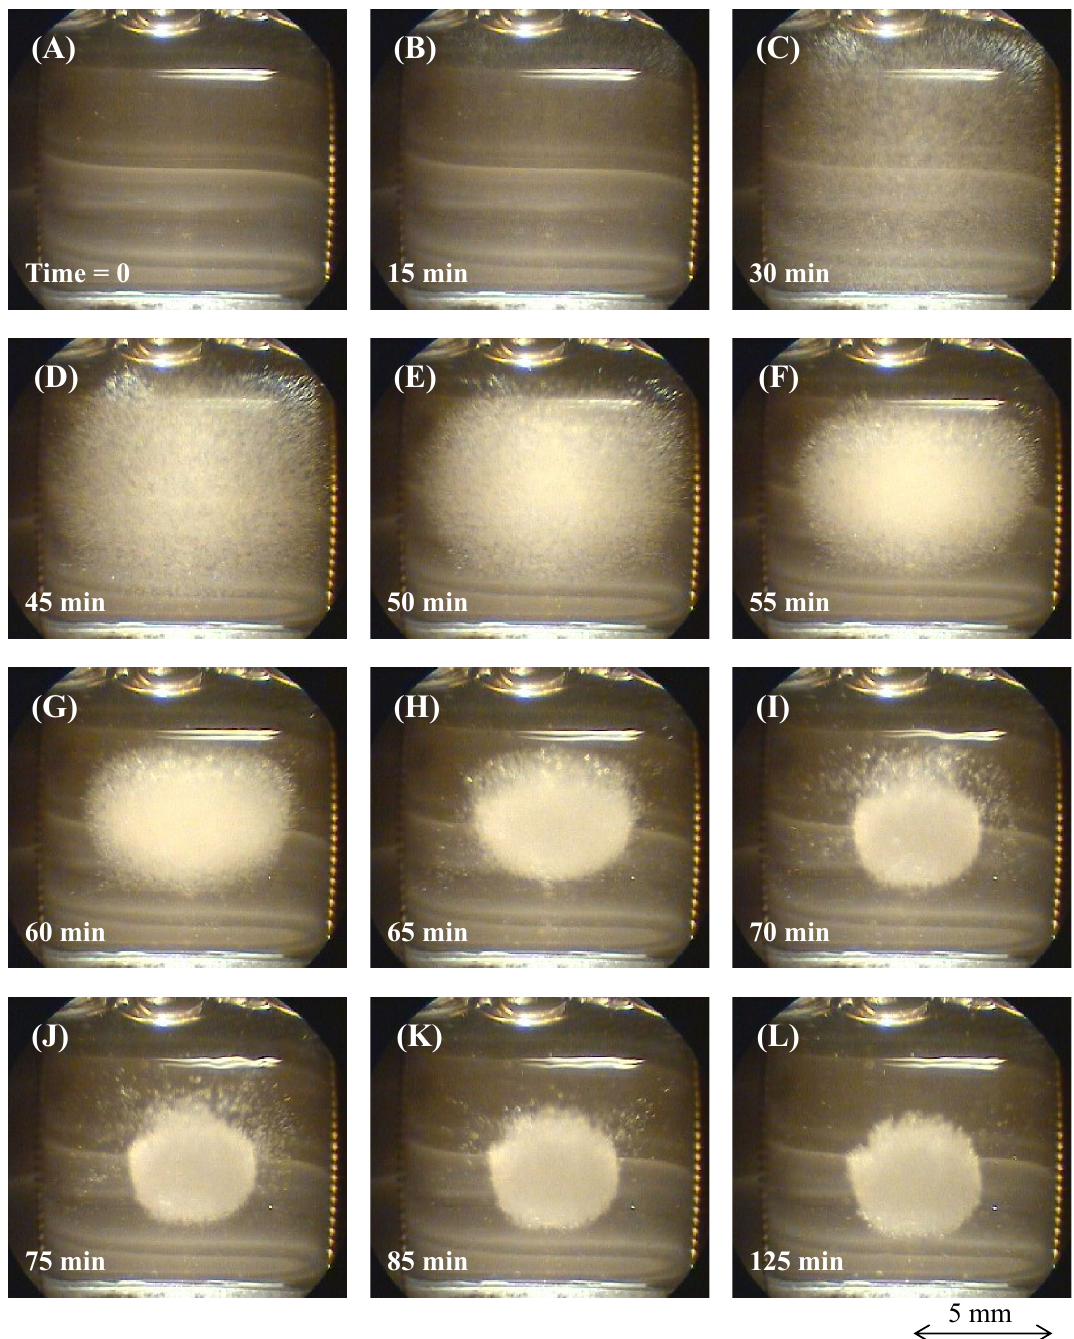
Figure 3. The series of photos of the contactless crystallization of HEWL. We used the type B booster, and the magnetic flux density at the coil center was 2.12 T. At 15 min, white fine crystallites appeared slightly above the solution. At 1 h, they slowly concentrated while levitating, and aggregated into a spherical shape. We kept the sphere crystal levitated all day and confirmed that it never contacted the grown to a larger size than that in Fig. 3I. We kept the crystal levitating all day, and we confirmed that it had never contacted the vessel. Thus, the sequence of photos in Fig. 3 provides evidence that we succeeded in the contactless crystallization of protein. As Supplementary Material in the crystallization process, a short movie recorded at 100 × speed (Supplementary Video 1) will be made available separately. Figure 4a–c are photos of the spherical crystal taken after the experiment. As pointed out by the arrows in Fig. 4A,C, its inside was hollow and the crystals (polycrystal) had grown into a spherical shell. As far as we know, such an unusual phenomenon has never been found before. We verified the reproducibility of this method. As shown in Fig. 5, the contactless crystallization was per- formed more than five times, not only by the type B booster (Fig. 5b) but also by the type A booster (Fig. 5a).